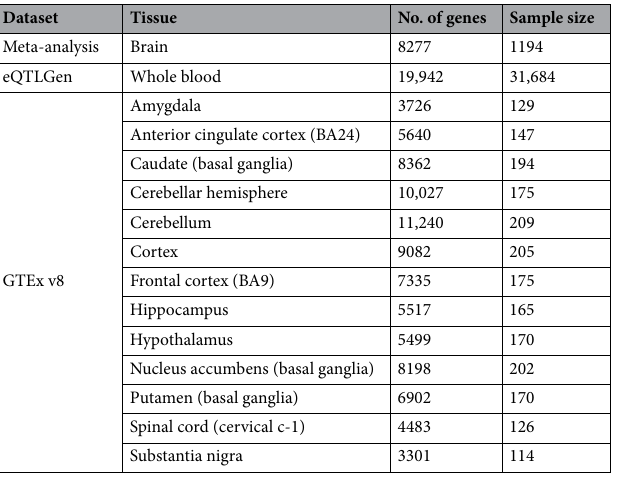
Table 2. List of datasets used in this study. The meta-analysis is taken from Qi et al. 28 which includes data from GTEx v6 30 , the Religious Order Study and Memory and Ageing Project (ROSMAP) 35 and CommonMind Consortium (CMC) 36 . eQTLGen Consortium (eQTLGen) 29 contains eQTLs from whole blood. GTEx v8 data is used to interrogate tissue-specific expression 30